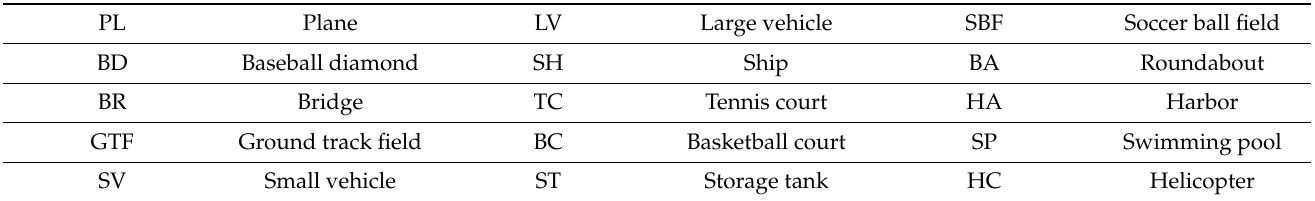
Table 4. Categories on the DOTA dataset and their corresponding